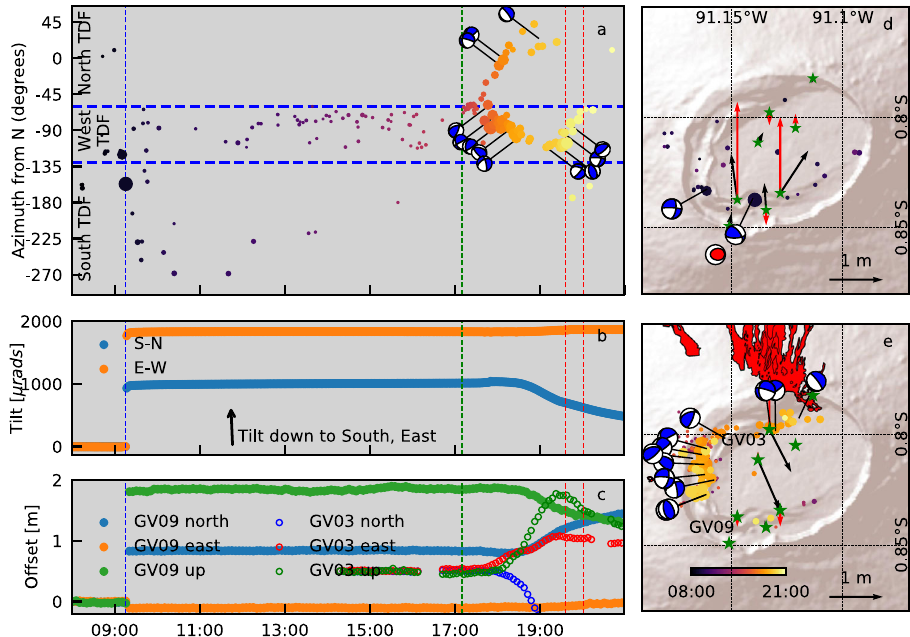
Fig. 4 Seismicity and deformation associated with the onset of eruption on 26 June 2018. A Azimuth of earthquake epicentres from centre of caldera and focal mechanisms of earthquakes as a function of time (UTC). Circle size indicates magnitude, as in Fig. 3B. Vertical dashed lines indicate timing of the Mw5.4 earthquake (blue), onset of seismic swarm (green), and onset of tremor pulses (red). B Tilt recorded at station SN14 (for tiltmeter location, see Fig. 1E). C Deformation recorded at cGPS stations GV09 and GV03. Before 09:15, all components plot at zero. D Earthquake epicentres, focal mechanisms, and horizontal (black) and vertical (red) cGPS displacements between 08:00 and 12:00, including the Mw5.4 earthquake. Red focal mechanism is